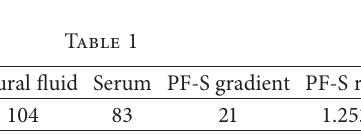
Figure 1: Chest radiograph illustrating worsening right pleural effusion (b) after thoracentesis (9 days prior) (a).